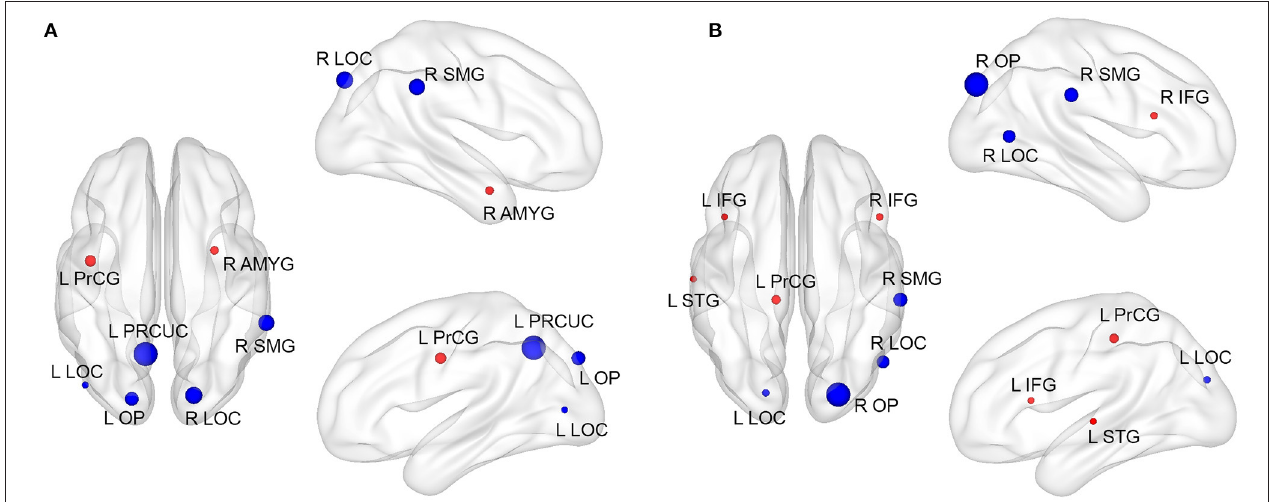
Stroke Patients < HCs